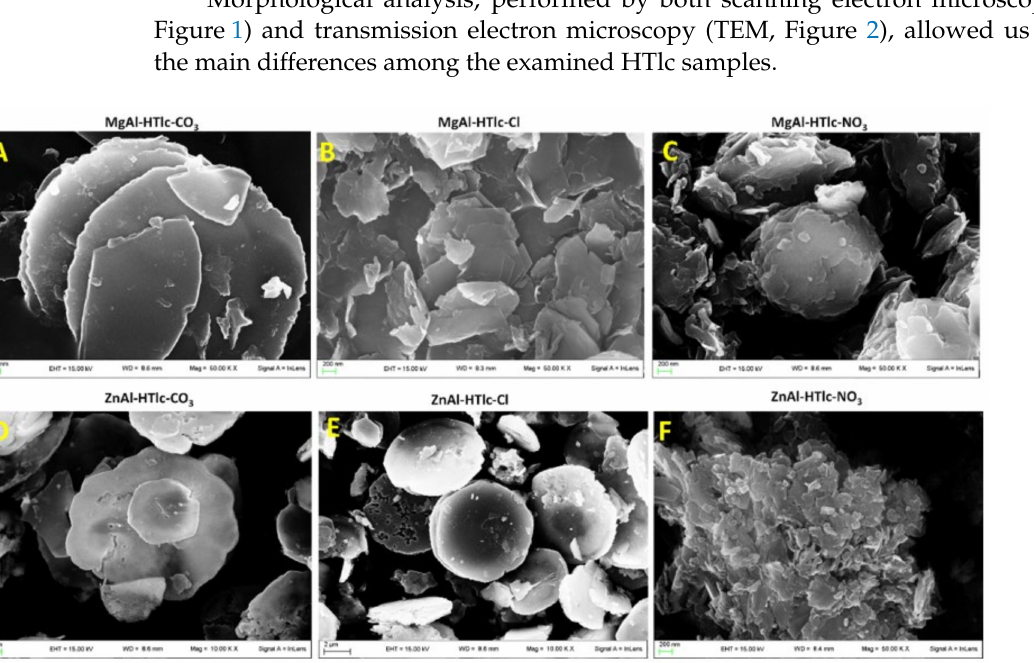
Figure 1. Micrographs obtained by SEM analysis of: MgAl-HTlc-CO 3 ( A ); MgAl-HTlc-Cl ( B ); MgAl- HTlc-NO 3 ( C ); ZnAl-HTlc-CO 3 ( D ); ZnAl-HTlc-Cl ( E ); ZnAl-HTlc-NO 3 ( F